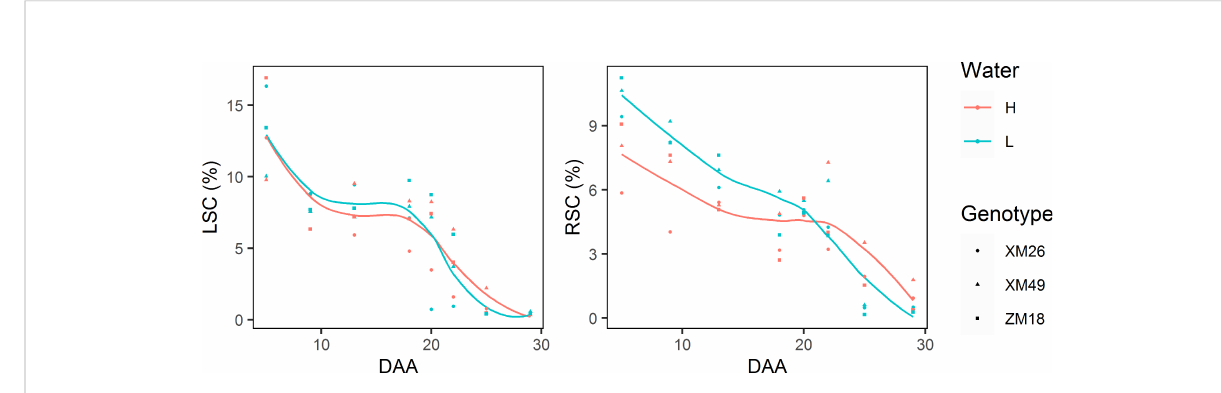
FIGURE 10 The dynamics of leaf sucrose concentration (LSC) and rachis sucrose concentration (RSC) in different winter wheat genotypes under different levels of irrigation. Lines represent values fi tted using the “ loess ” method and points denote observations. DAA, days after anthesis; H, high- water treatment; L, low-water treatment; XM26, Xinmai-26; XM49, Xinmai-49; ZM18, Zhoumai-18.